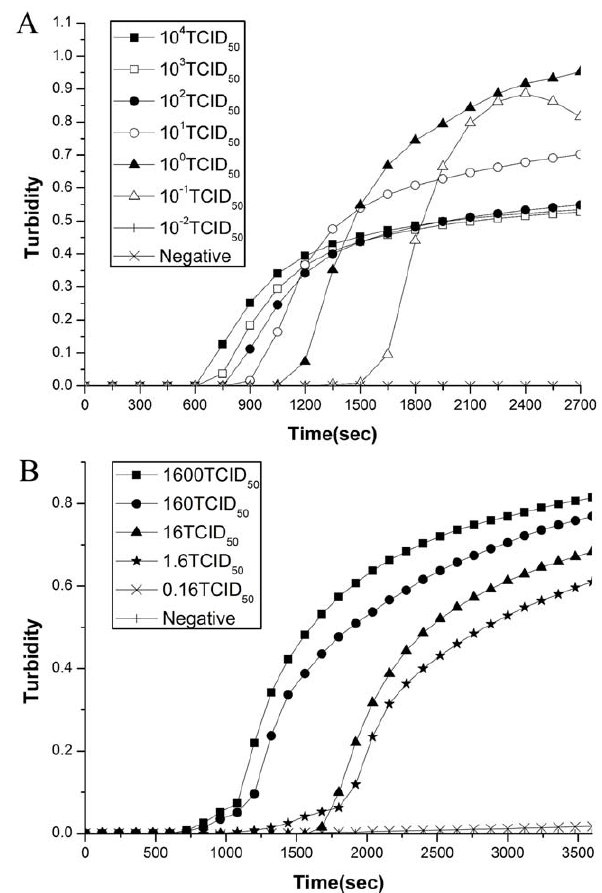
Figure 2. Sensitivities of the RT-LAMP and direct RT-LAMP assays for the detection of human EV71. The assay was carried out using different concentrations of RNA from a titrated EV 71 subgenotype C4 isolate (Strain FY17.08/AN/CHN/2008, GenBank acces- sion no. EU703812) and monitored by real-time measurement of turbidity. The detection limits of the RT-LAMP (Figure 2A) and direct RT- LAMP (Figure 2B) assay for EV71 were 0.1 and 1.6 TCID 50 per reaction, respectively.